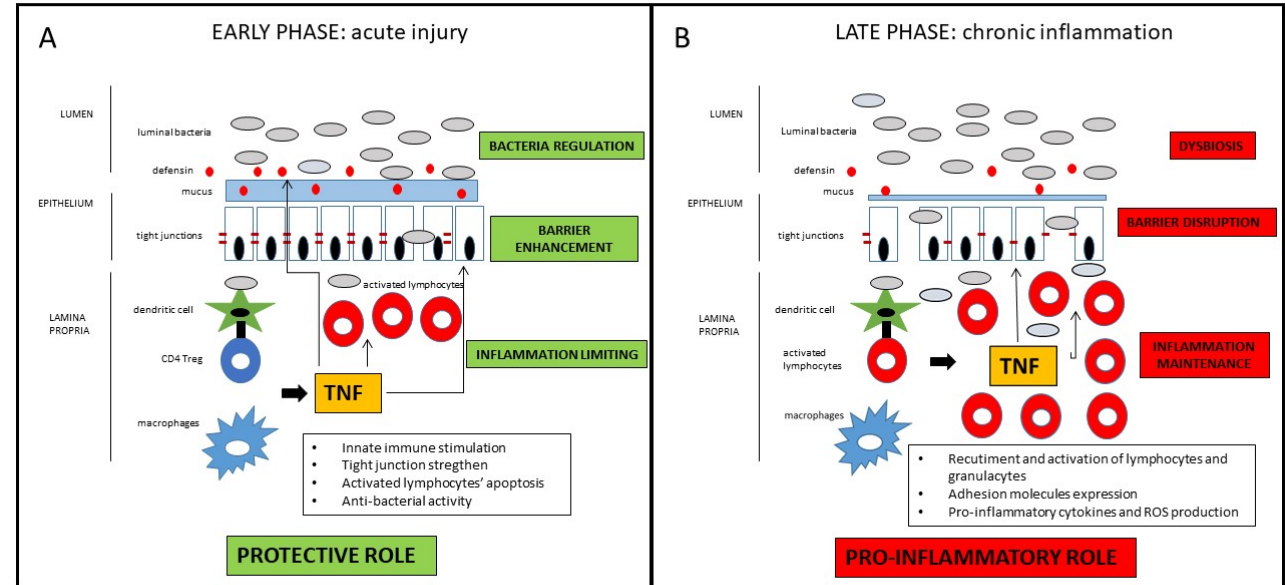
Figure 1. Schematic representation of the dichotomous role of TNF in CD pathogenesis. In the early phase of the inflammatory process, TNF has protective effects on the intestinal mucosa, whereas in the late phase of disease, TNF has consistent pro-inflammatory effects. For detailed description, please refer to the text.